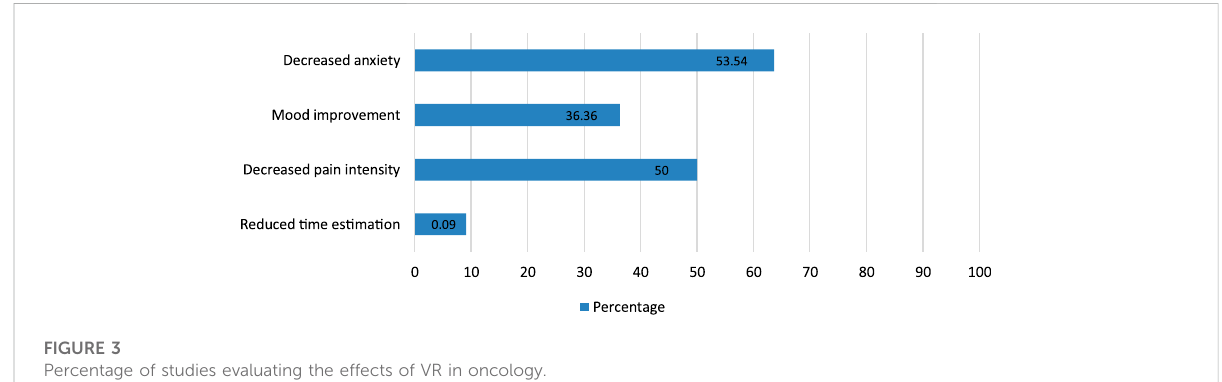
FIGURE 3 Percentage of studies evaluating the effects of VR in